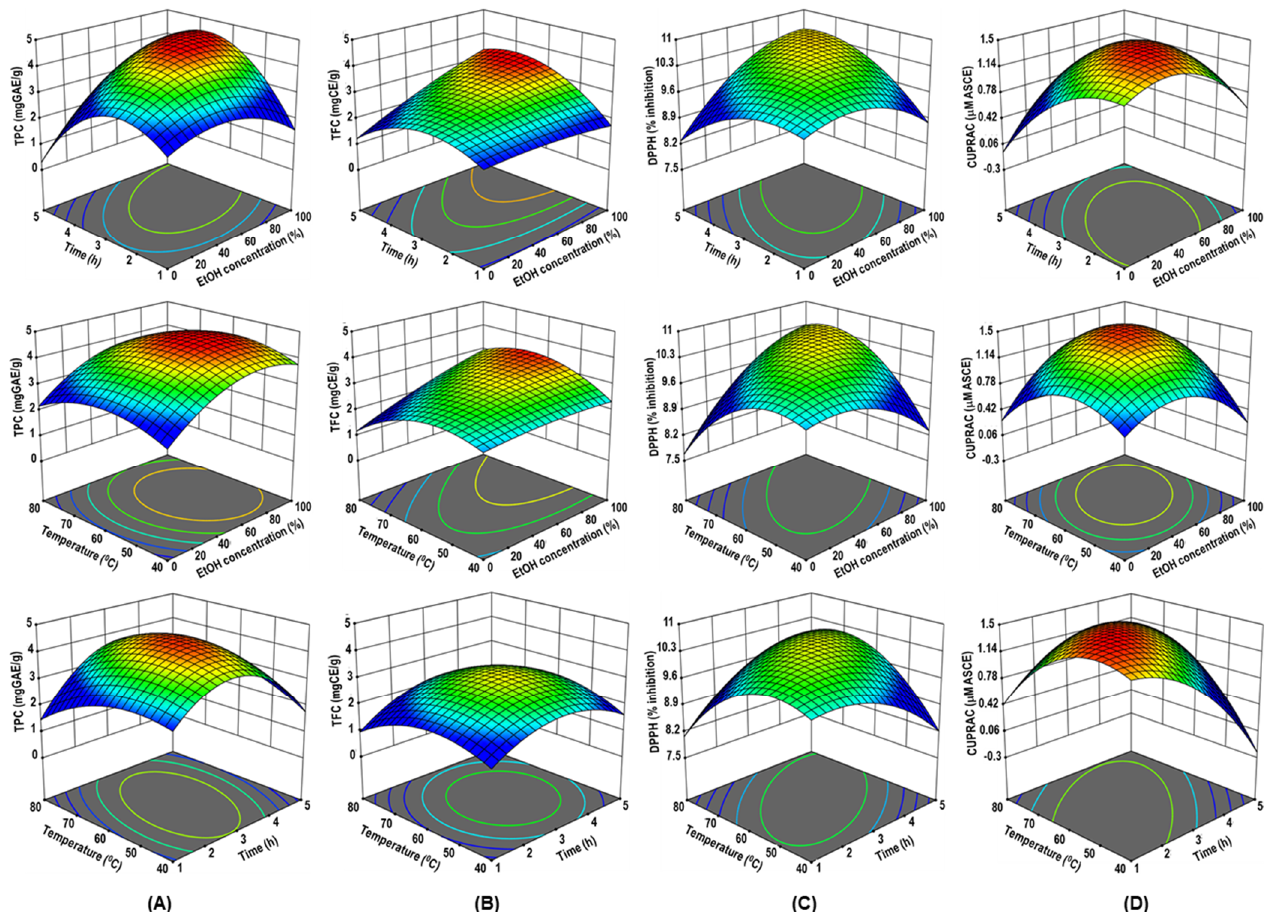
Figure 1. The three-dimensional (3D) response surface plots of RADP extraction on ethanol concentration, time, and temperature for TPC ( A ), TFC ( B ), DPPH radical scavenging activity ( C ), and CUPRAC ( D ) as a function of significant interaction factors for RSM.